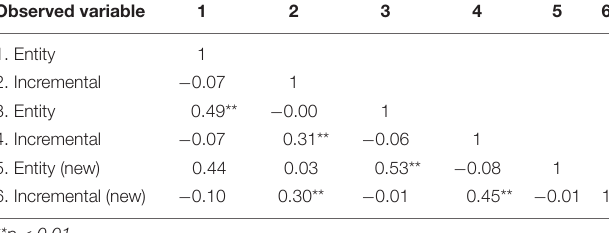
TABLE 8 | Correlations among items in 6-item version.